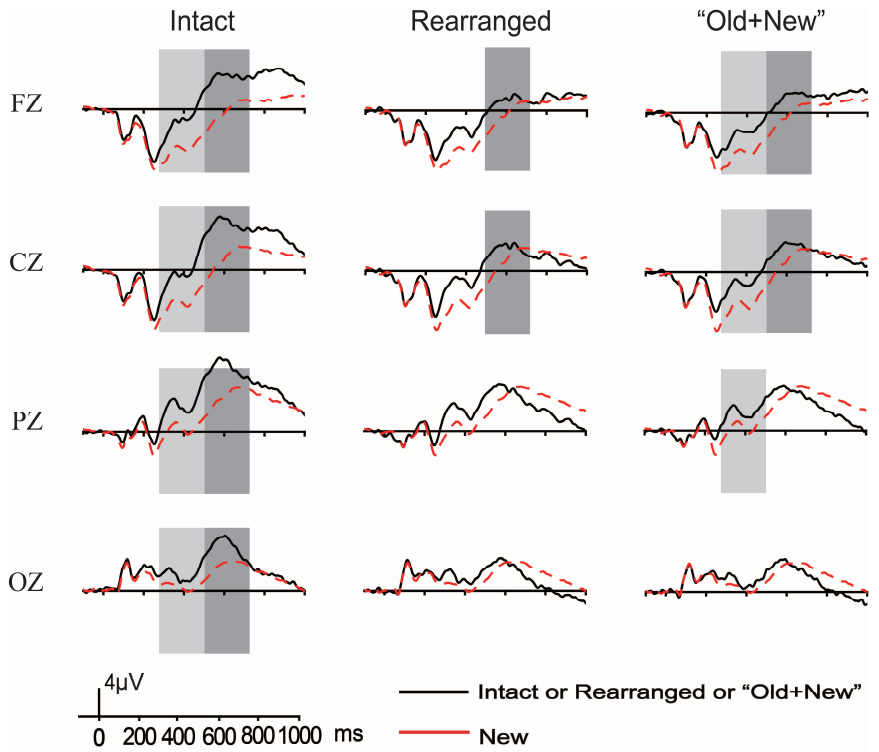
Figure 6. The grand-average ERP waveforms elicited by correctly rejected new pairs with those of correctly identified intact, rearranged, and “old + new” pairs of taxonomic relations, and the boxes mark the reliable FN400 and